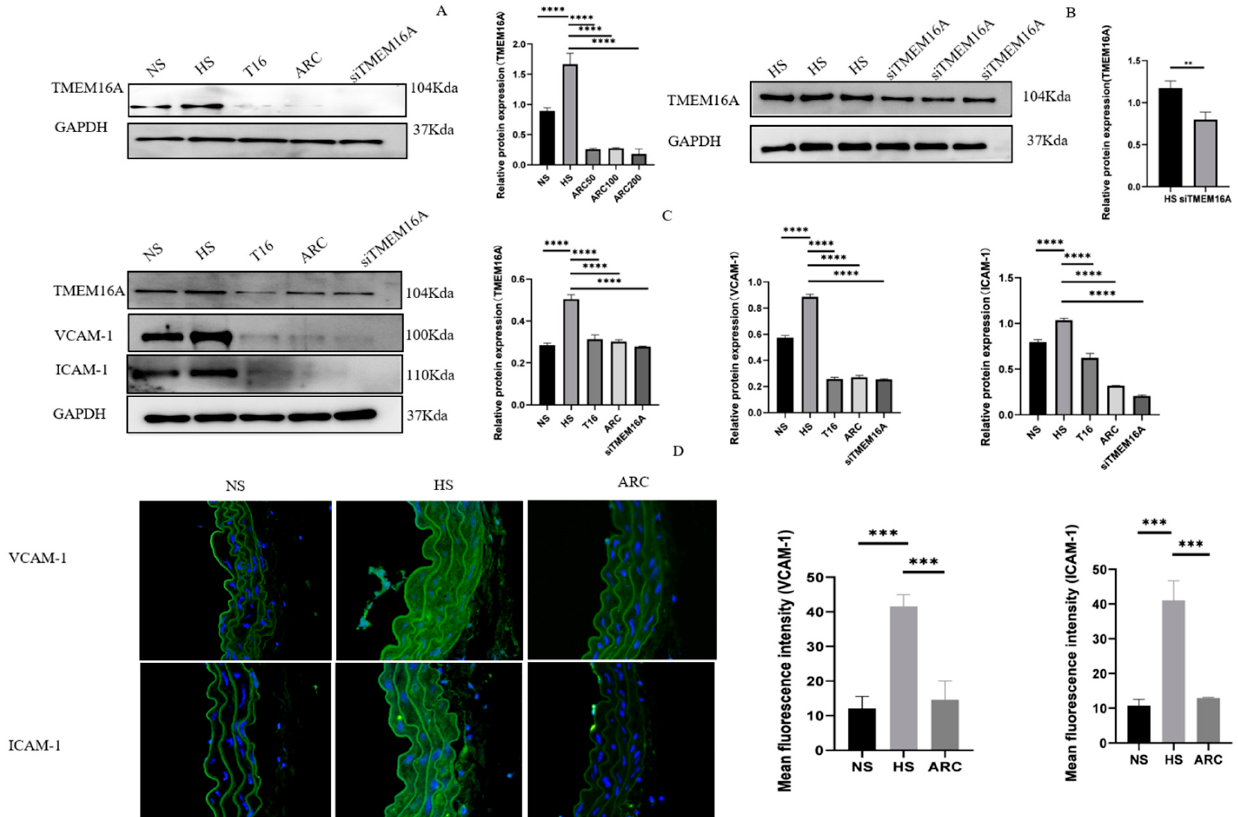
Figure 4. ( A ) Western blotting results showed discernible reduction in TMEM16A proteins in VSMCs after treating with 50, 100, and 200 uM arctigenin for 24 h, mean protein was quantified using one ‐ way ANOVA and p ‐ value adjusted for multiple comparisons with Sidak multiple ‐ com ‐ parison test (n = 3), **** p < 0.0001; ( B ) 30 uM siTMEM16A knockdown TMEM16A protein for 24 h in the TMEM16A knockdown cells compared to the HS group. Data are expressed as mean ± SD, ** p < 0.01 t ‐ test ( n = 3); ( C ) The Western blotting results showed that incubating aortic VSMCs with 10 uM T16Ainh ‐ A01, 100 uM arctigenin and 30 uM siRNA TMEM16A led to a decrease in TMEM16A, VCAM ‐ 1 and ICAM ‐ 1. Data are expressed as mean ± SD, and relative protein expression was quan ‐ tified using one ‐ way ANOVA and p ‐ value adjusted for multiple comparisons with Sidak multiple ‐ comparison test ( n = 3), **** p < 0.0001. ( D ) Microscopic images showed immunofluorescence stain ‐ ing of VCAM ‐ 1 and ICAM ‐ 1 (green) in thoracic aortas ( n = 4); blue represents nucleus. Mean fluo ‐ rescence was quantified using one ‐ way ANOVA and p ‐ value adjusted for multiple comparisons with Sidak multiple ‐ comparison test ( n = 4), *** p < 0.001. NS: normal salt group, HS: high ‐ salt group,